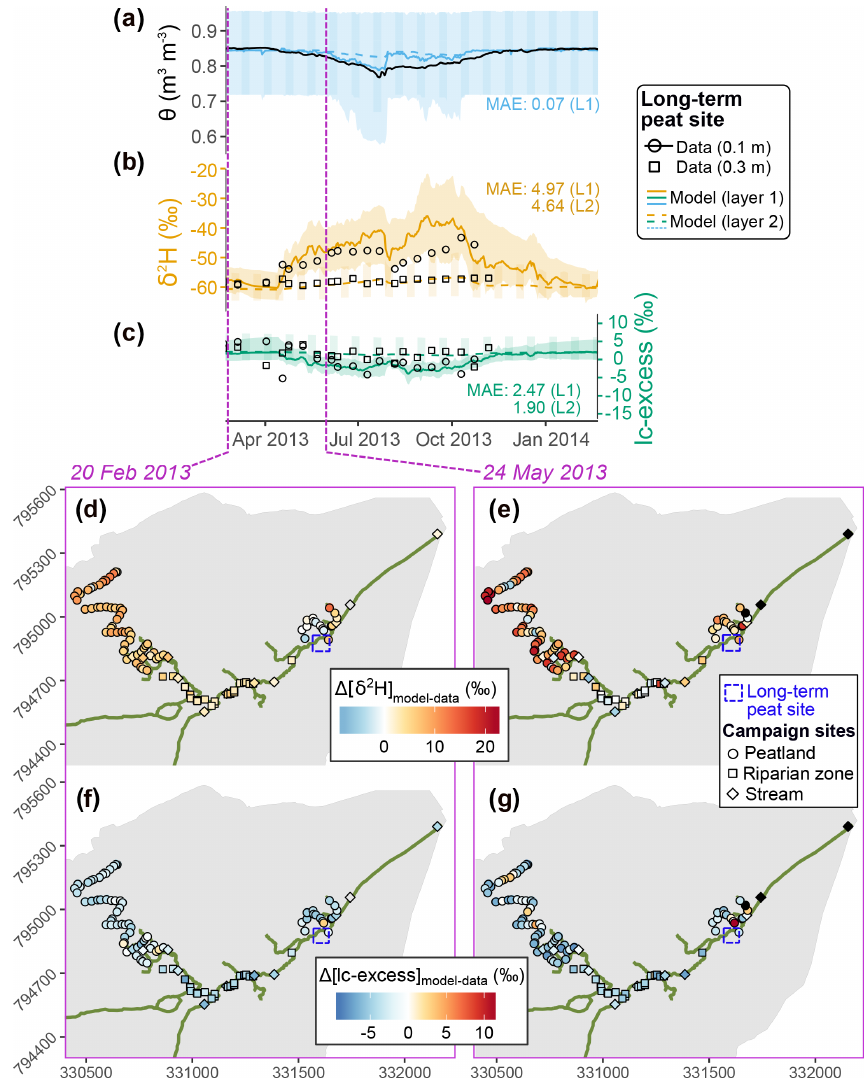
Figure 4. (a–c) Time series of soil volumetric water content ( θ ) and isotopic composition ( δ 2 H and lc-excess) at the peat site indicated by purple cross in the bottom maps. Measurements at a given depth are shown in black while colours display the ensemble medians and 90% intervals of simulations in the two uppermost soil layers. (d–g) Model–data difference at two given days when samples were collected in the valley bottom, for deuterium (d–e) and lc-excess (f–g) ; black symbols indicate an absence of sample on one of the two dates, and the median model–data MAE values are